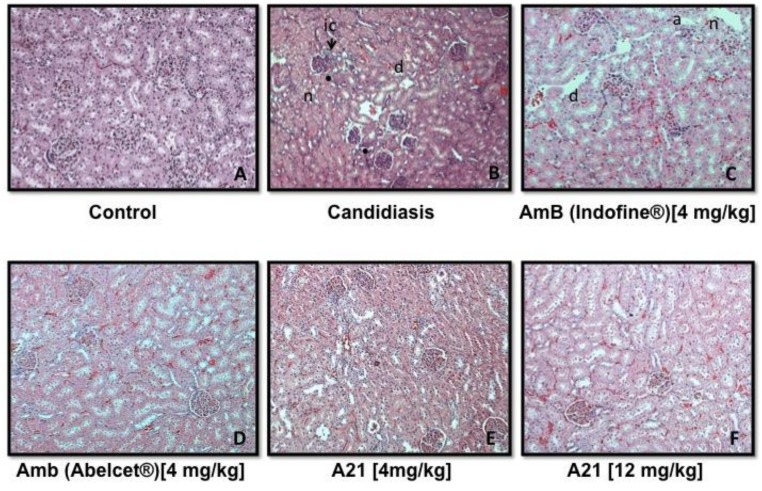
Histopathological analysis of kidney obtained five weeks after Candida albicans inoculation in mice.(A) Kidney of Balb-C mouse with normal appearance. (B) The kidney shows severe pyelonephritis with fungal infiltration (●). The image shows clusters of dilated degenerative tubules (d) containing exfoliated necrotic epithelium admixed with necrotic tubules (n). The inflammatory infiltration (ic) damaged the lining of the tubules. Renal tubular nephrosis was observed. (C) Kidney from a representative mouse with candidiasis treated with a daily IP dose of 4 mg/kg AmB (DMSO) during the last two of the five weeks. Clusters of dilated degenerative tubules (d) containing exfoliated necrotic epithelium admixed with necrotic (n) and apoptotic tubules (a) appear. (D) Kidney from a representative mouse with candidiasis treated with a daily IP dose of 4 mg/kg AmB (Abelcet®) during the last two of the five weeks, with normal appearance. (E) Kidney from a representative mouse with candidiasis treated with a daily IP dose of 4 mg/kg A21 during the last two of the five weeks. The kidney shows normal appearance. (F) Kidney from a representative mouse with candidiasis treated with a daily IP dose of 12 mg/kg A21 during the last two of the five weeks, showing a normal appearance.